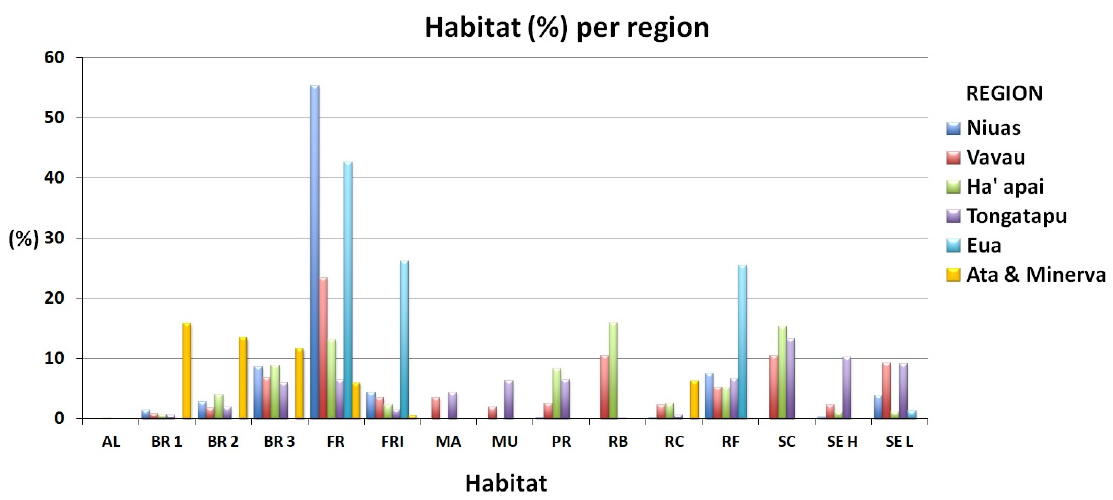
Figure 4. Total habitat percentage occurrence of the 15 main habitats classes/subzones in the five Tonga regions, Ata Island and Minerva Reef. For habitat abbreviations on the x -axis, see Table 2.